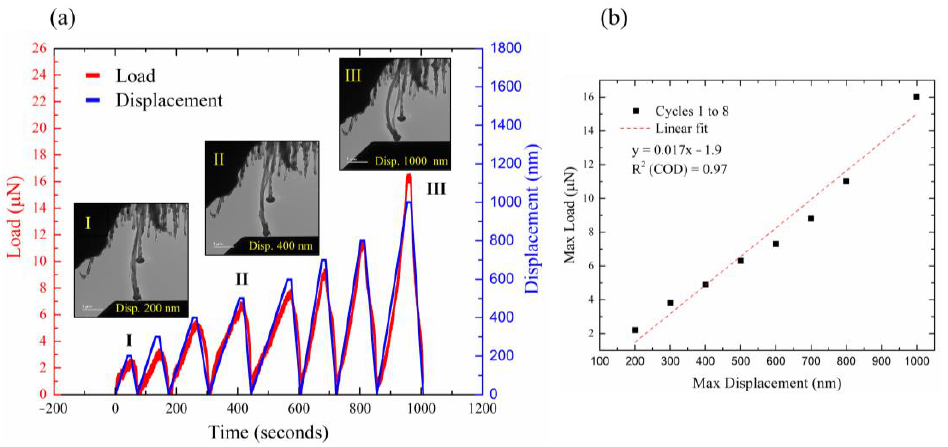
Figure 2. In situ compression tests of a single MWCNT. ( a ) Load–time–displacement curves of eight consecutive compression cycles, each with increased displacement. Inset: corresponding TEM images of selected cycles at the maximum displacement (cycles 1 (I), 4 (II), and 8 (III)); bright-field mode, 200 kV. ( b ) Linear fitting of the maximum load–maximum displacement curve of the same eight cycles, demonstrating the elastic response of the